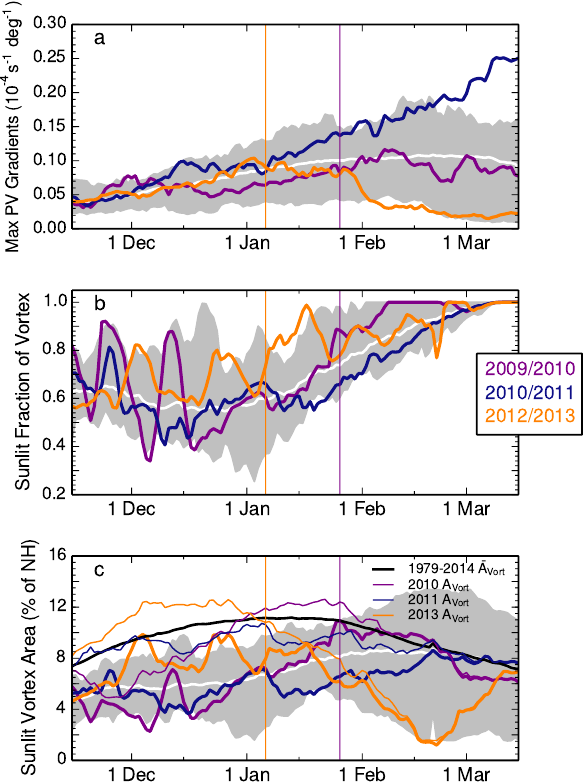
Figure 6. Time series from MERRA reanalysis at 490K of (a) potential vorticity (PV) gradients as a function of EqL (10 − 4 s − 1 deg − 1 ) and sunlit vortex area (SVA) expressed as (b) a fraction of the total vortex area and (c) a fraction of the hemi- sphere, with total vortex area shown as thin lines. Shading and line colors are as in Fig.